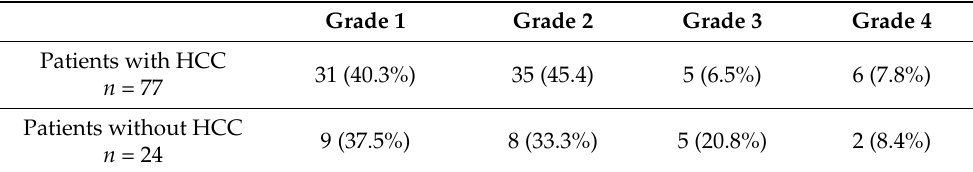
Table 3. The distribution of subjects according to PVT extension.